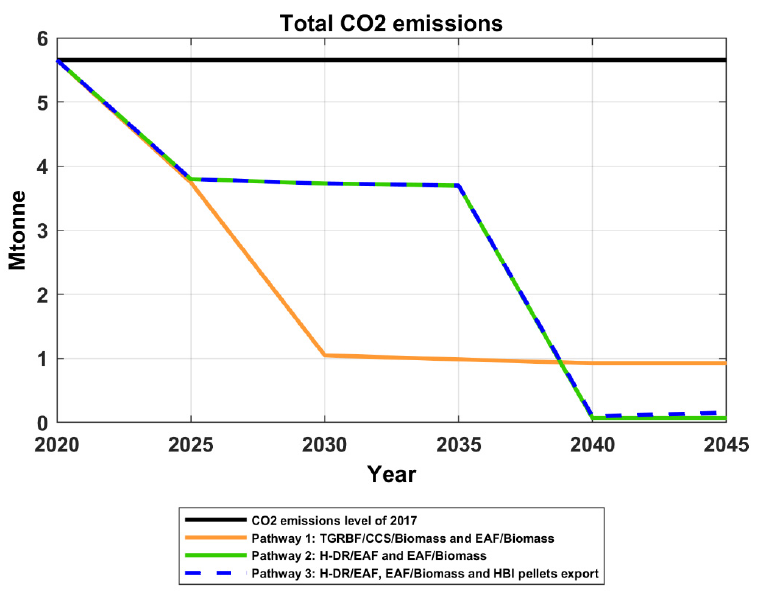
Figure 7. Development of CO 2 emissions for the Swedish steel industry pathways from 2020 to 2045.